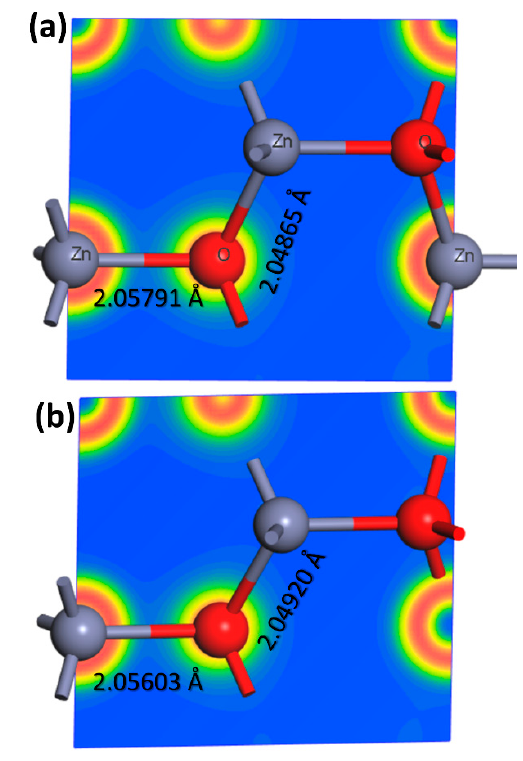
Figure 7. Charge density distribution at the same plan for both ZnO ( a ); and 5%Fe doped ZnO ( b ).